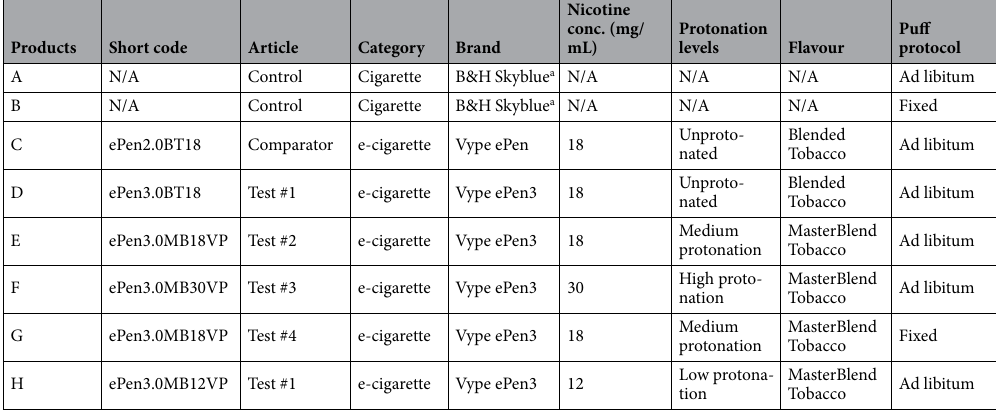
Table 1. Study arms and product characteristics. N/A not applicable. a Benson & Hedges Skyblue—7 mg ISO tar